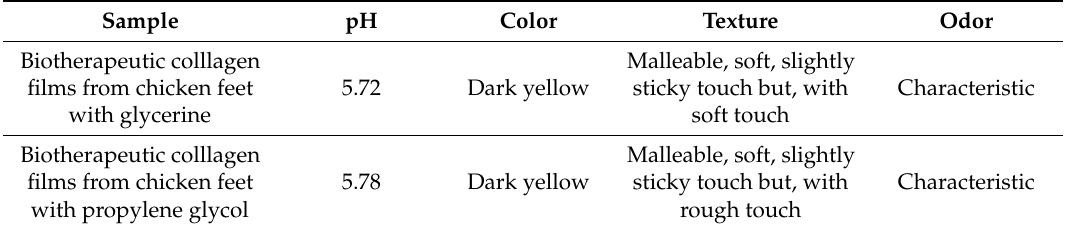
Table 10. Comparative organoleptic properties of biotherapeutic films obtained from chicken feet using propylene glycol and glycerin.